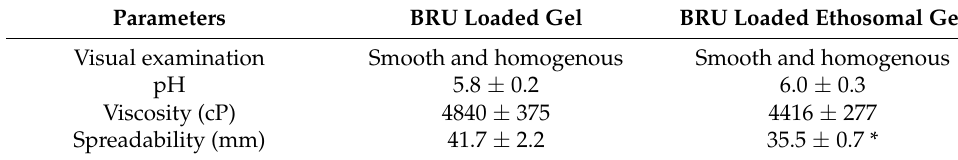
Table 4. Characterization of BRU loaded gel and ethosomal gel formulations.